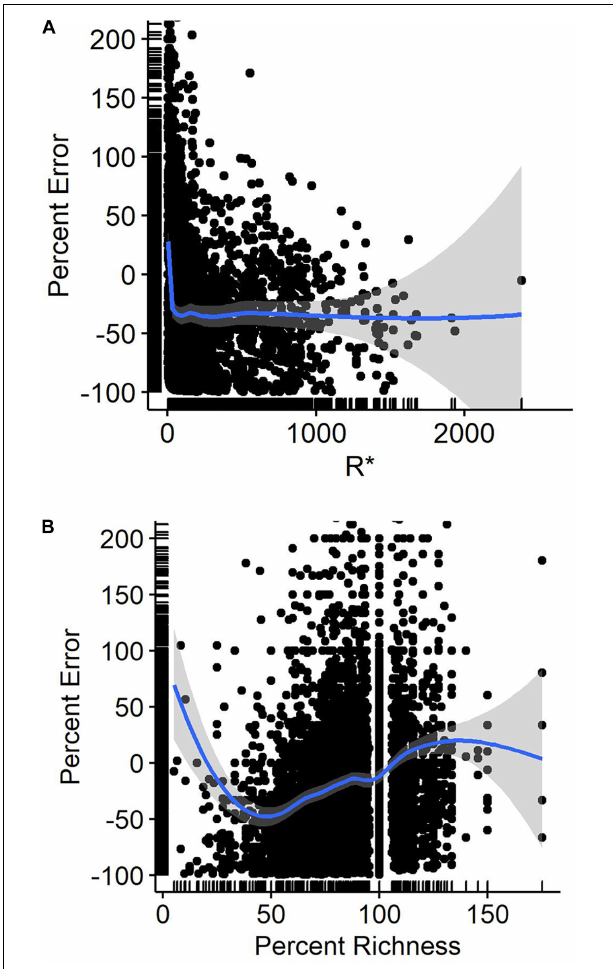
FIGURE 2 | Percent error in eBird waterbird counts as a function of (A) reference (benchmark) counts ( R* ), and (B) percent richness of waterbird species detected at Philomath ponds. Lines are Loess regression lines with 95% confidence intervals.